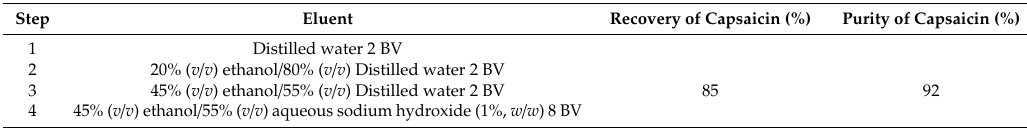
Table 8. The optimized gradient elution conditions and results.